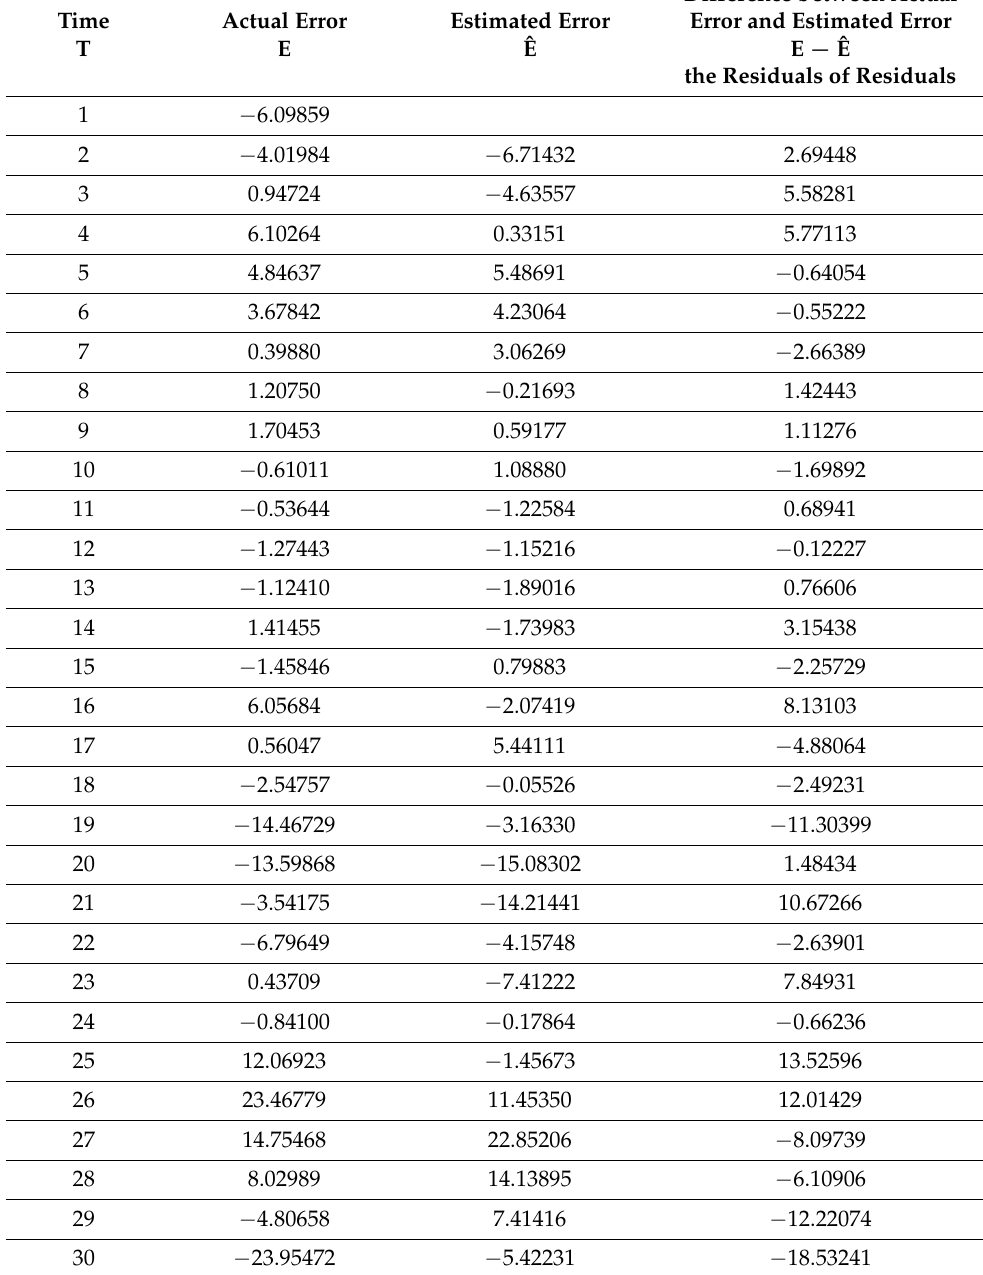
Table A6. Calculation of the residuals of residuals in the sample period